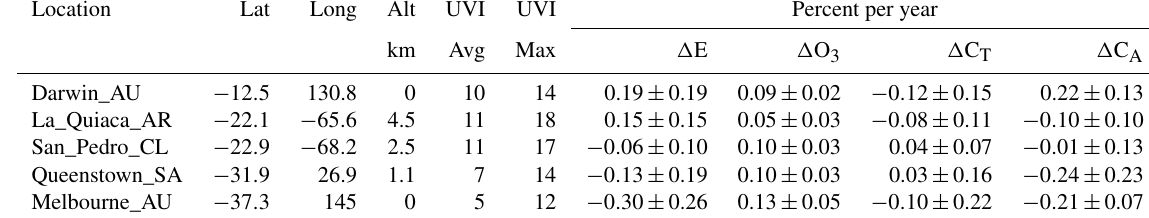
Table 4. Summary for seven Southern Hemisphere sites (errors are 1 σ ).